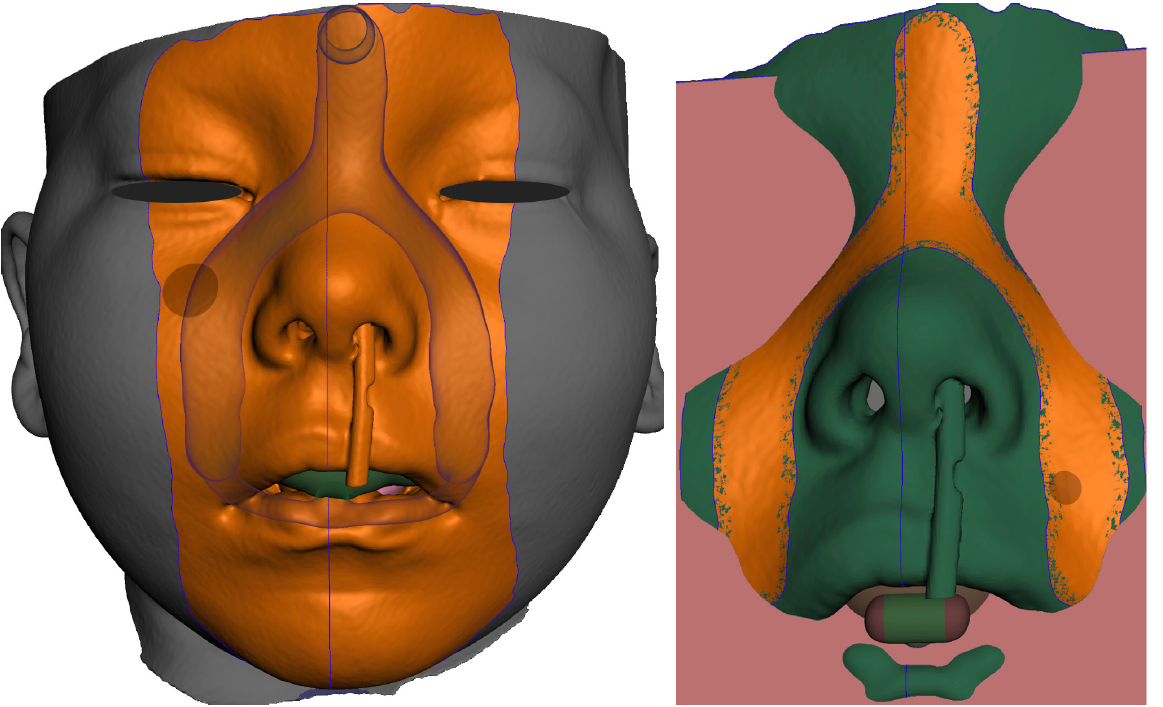
Figure 15. In extraoral part creation—in region definition, the only relevant part of the segmented facial surface from the CT/CBCT is used. Import of 2D plane novelized on the eye pupils can be utilized as a guide for better appliance symmetry. Select tool, -> optimize boundaries—keystrokes “O”, “B” and offset by 0.1 mm from the face surface. Export surface as separate object keystrokes “Y”.